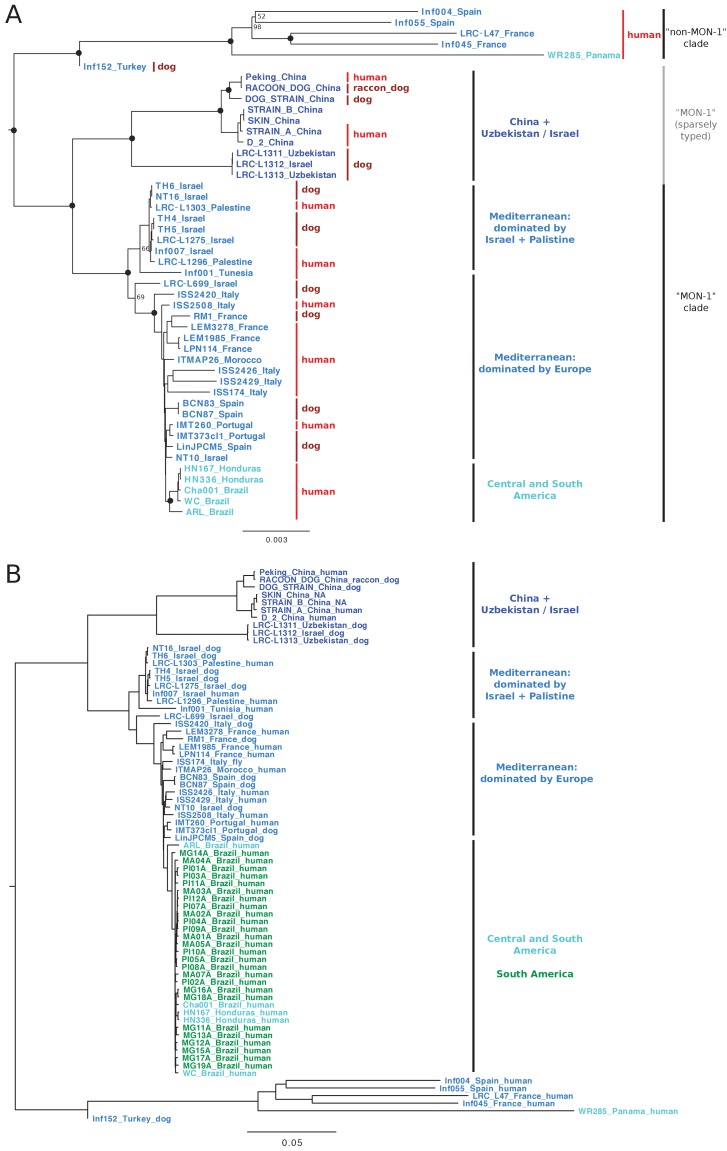
Sample phylogeny of the Linf1 group.(A) The phylogeny displays a sub-tree of the phylogeny in Figure 1. Bootstrap values are shown for prominent nodes in the phylogeny as black circles for values of 100 and otherwise the respective support value. The two main subclades differentiate MON-1 from non-MON-1 samples (annotation based on Figure 1—figure supplement 1) and sample colours indicate the geographic origin, that is Asia (dark blue), Mediterranean (pale blue) and South American (turquois). Sample names are annotated by their country of origin. The host the parasite was isolated from is indicated in bright and dark red, respectively. (B) Phylogeny of Linf1 samples including additional strains isolated from human infections from three different states in Brazil: Maranho (MA), Minas Gerais (MG) and Piau (PI) (Carnielli et al., 2018) (coloured in green).